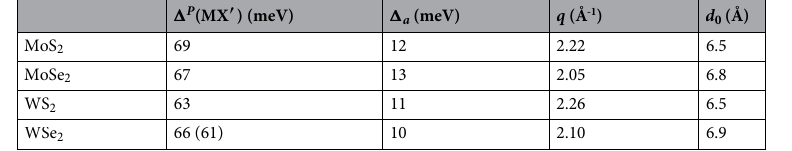
P (MX ′ ), together with the parametrisation of P ( r d ) , Eq. (1), calculated using the QE code. 0 , P